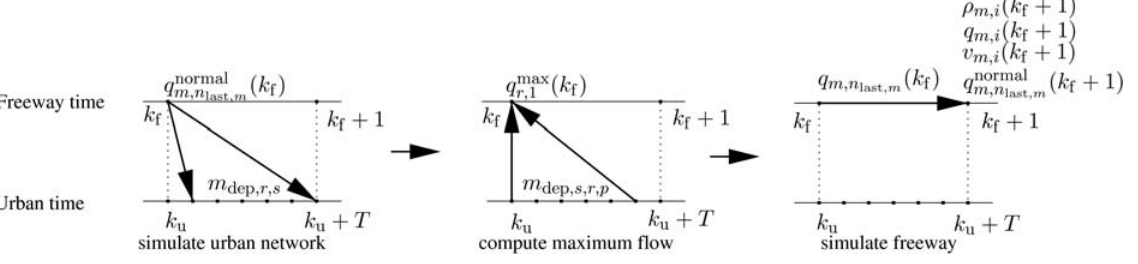
Figure 5. Order of computations during a simulation At the bottom each subfigure shows the urban time steps, at the top the freeway time steps. k the number of arriving vehicles in the The first subfigure shows that with the flow at time f urban network can be computed for time . Next, as shown in the second sub- figure, the urban variables at time steps are used to adapt the flows at time k . Last, the freeway variables on time are computed with the variables at f